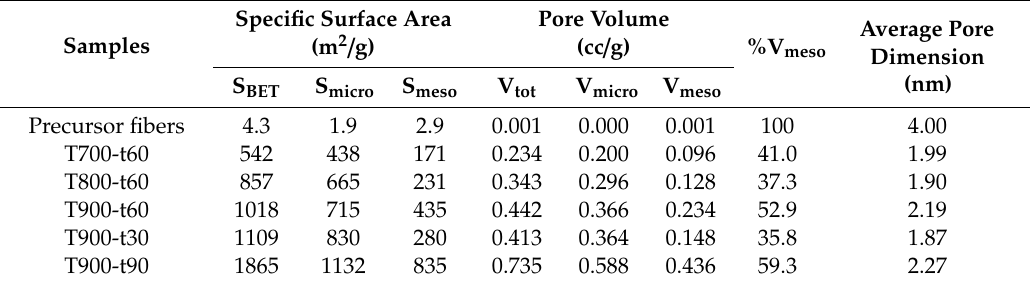
Table 1. The pore properties of